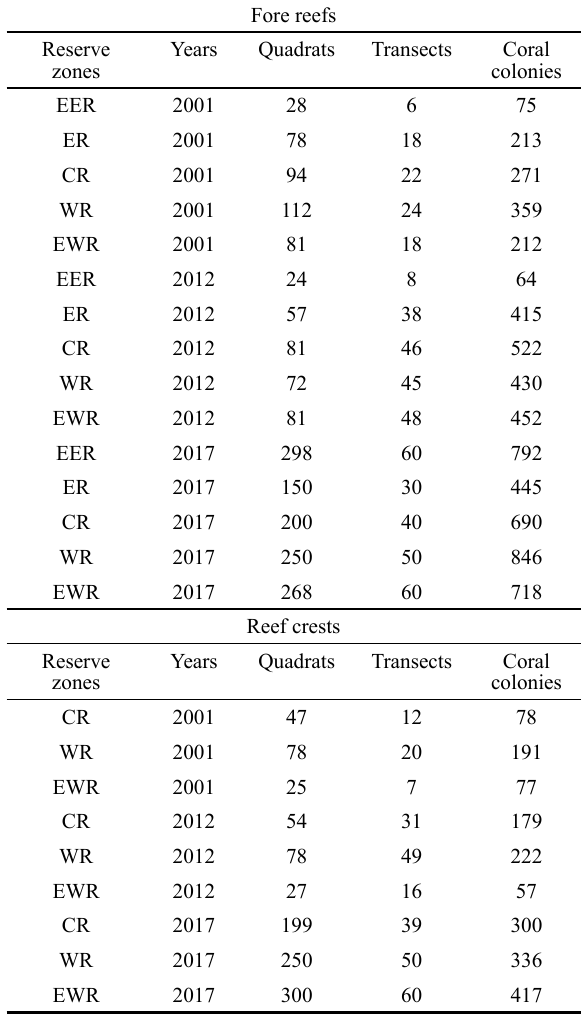
Table 1. – Number of quadrats used to study crustose coralline algae and number of transects used for corals. Number of coral colonies per reserve zone on the reef crests and fore reefs. Reserve xones: EWR, Westernmost Reserve; WR, Western Reserve; CR, Central Reserve; ER, Eastern Reserve; EER, Easternmost Reserve.